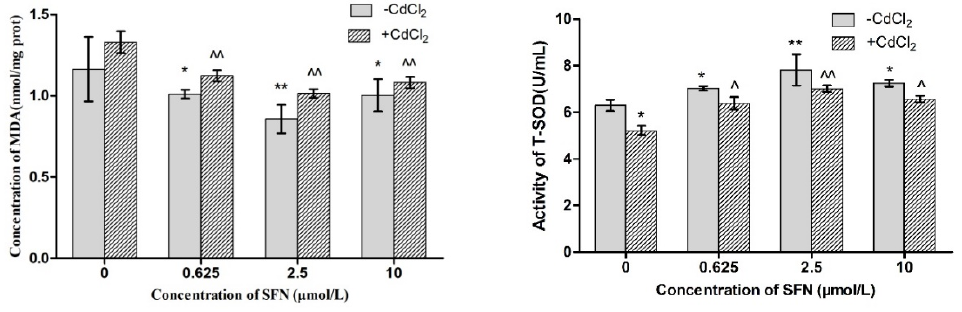
Figure 6. Effects of SFN on the MDA content and T ‐ SOD activity in Cd ‐ exposed TM4 cells * p < 0.05 as compared to the control group, ** p < 0.01 as compared to the control group, ^ p < 0.05 as compared to the Cd group, ^^ p < 0.01 as compared to the Cd group.